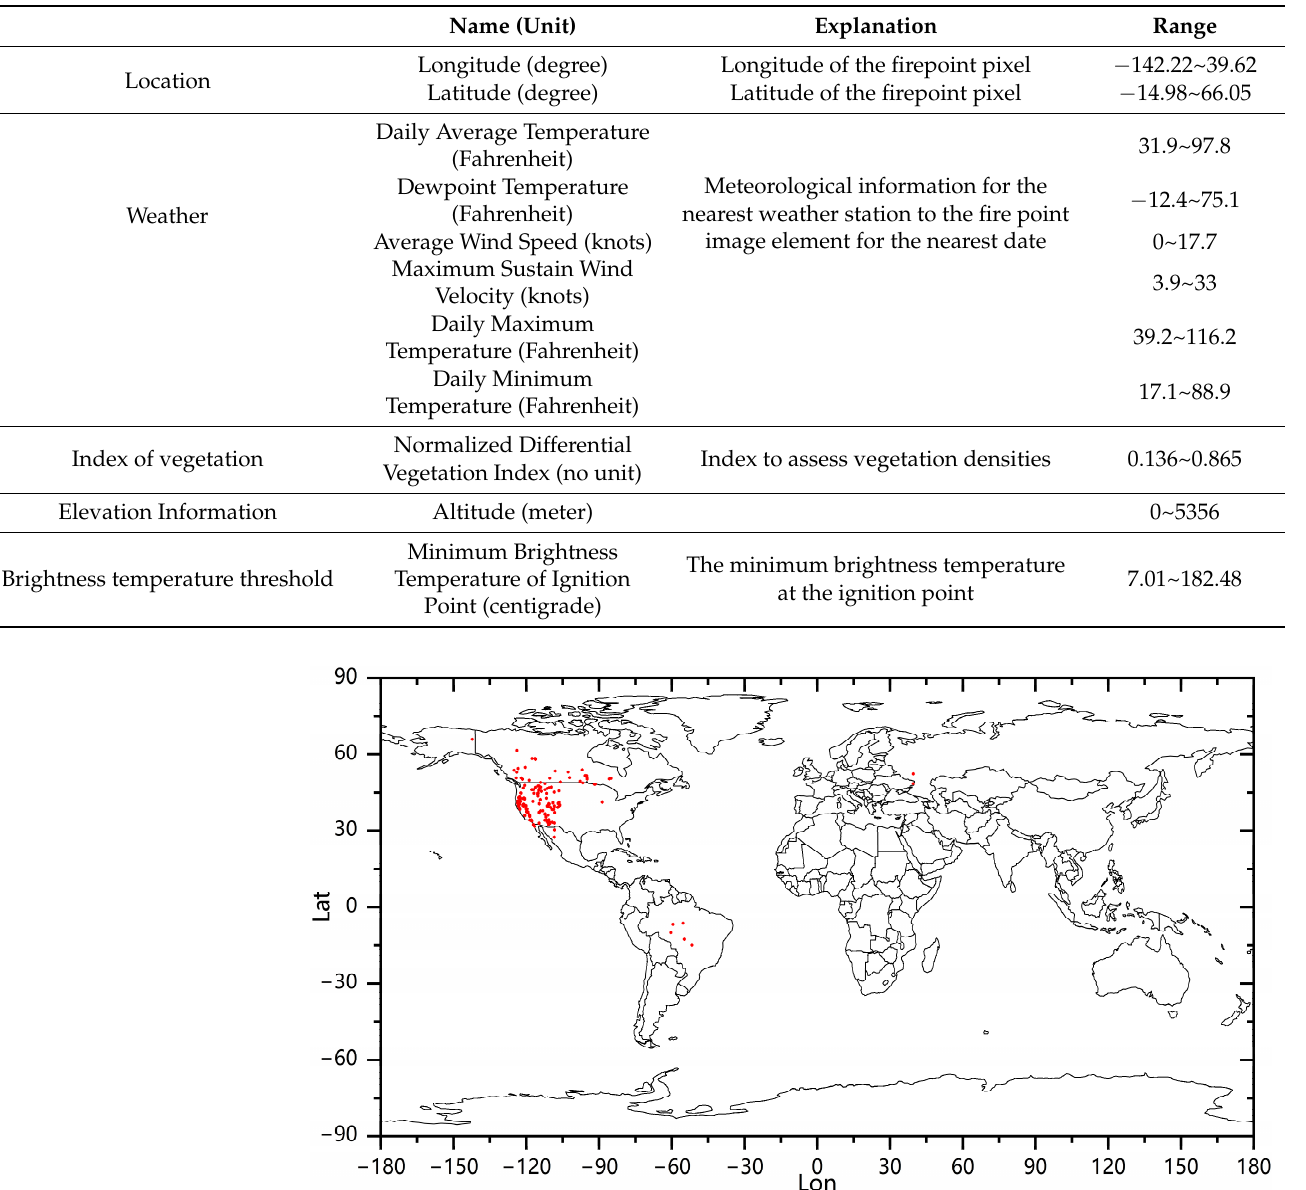
Figure 8. Global distribution map of all dynamic brightness temperature threshold sample points in the MODIS_DT_Fire dataset. The red dots are sample points.